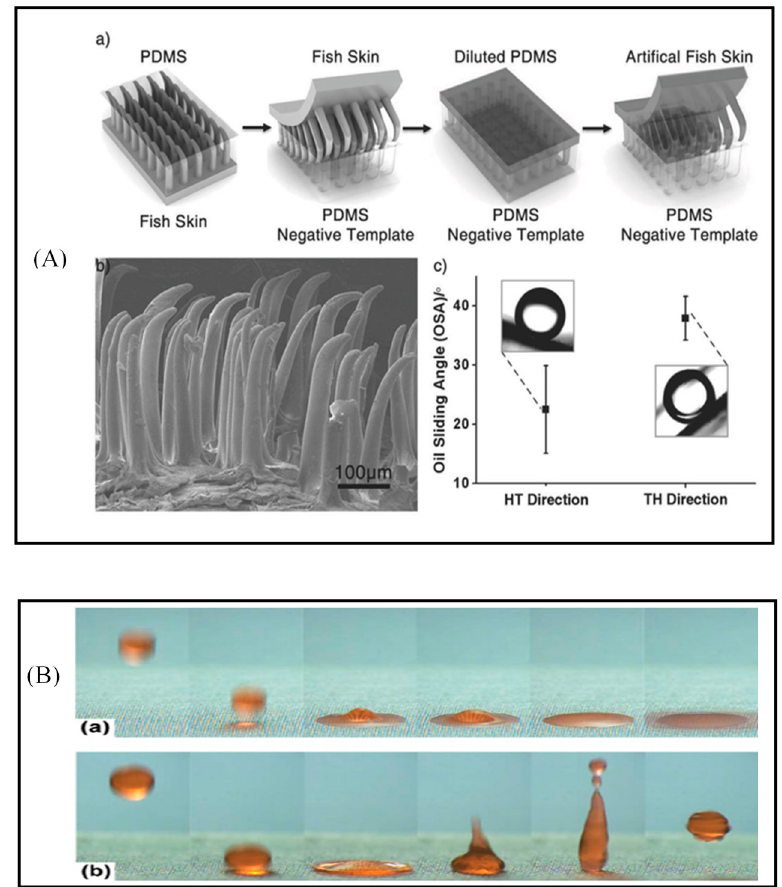
Figure 3. ( A ) (a) Illustration of the fabrication process for artificial fish skin; (b) SEM image of artificial fish skin fabricated by toluene-diluted PDMS; (c) Chart of anisotropic oil sliding angle (OSA) on oxygen-plasma-treated PDMS fish skin. The OSA values are 22.5° ± 7.3° along the head tail (HT) direction and 38.7° ± 3.7° along the TH direction. Reprinted with permission from [76]. Copyright Wiley 2013; ( B ) Bouncing behavior of water droplets on the upper image: (a) pristine and (b) nanostructured surfaces: superhydrophobic silk fabric. Reprinted with permission from [80]. Copyright RSC 2014.